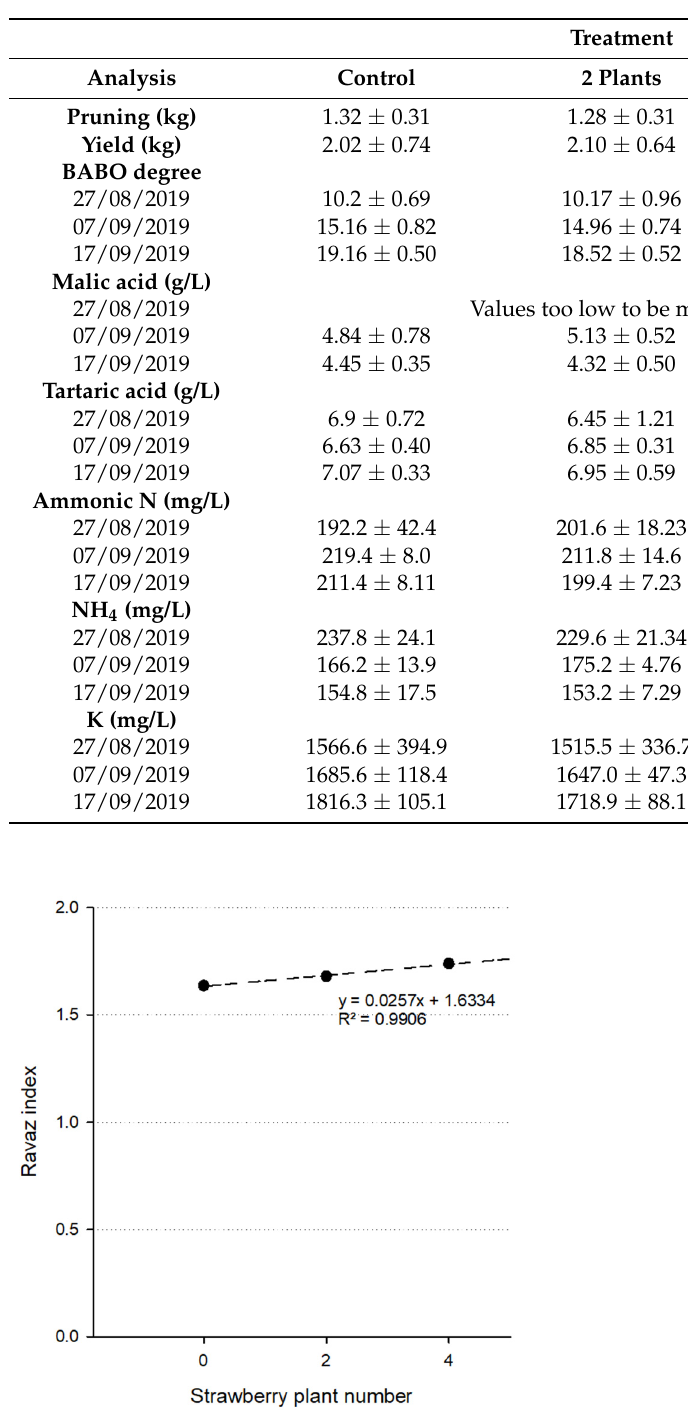
Table 1. Weight of vine pruning and grape yield and data from analyses of grape juice at three times during the grape ripening process with mean ± SD. All differences among treatments were not significant for Tukey HSD test.